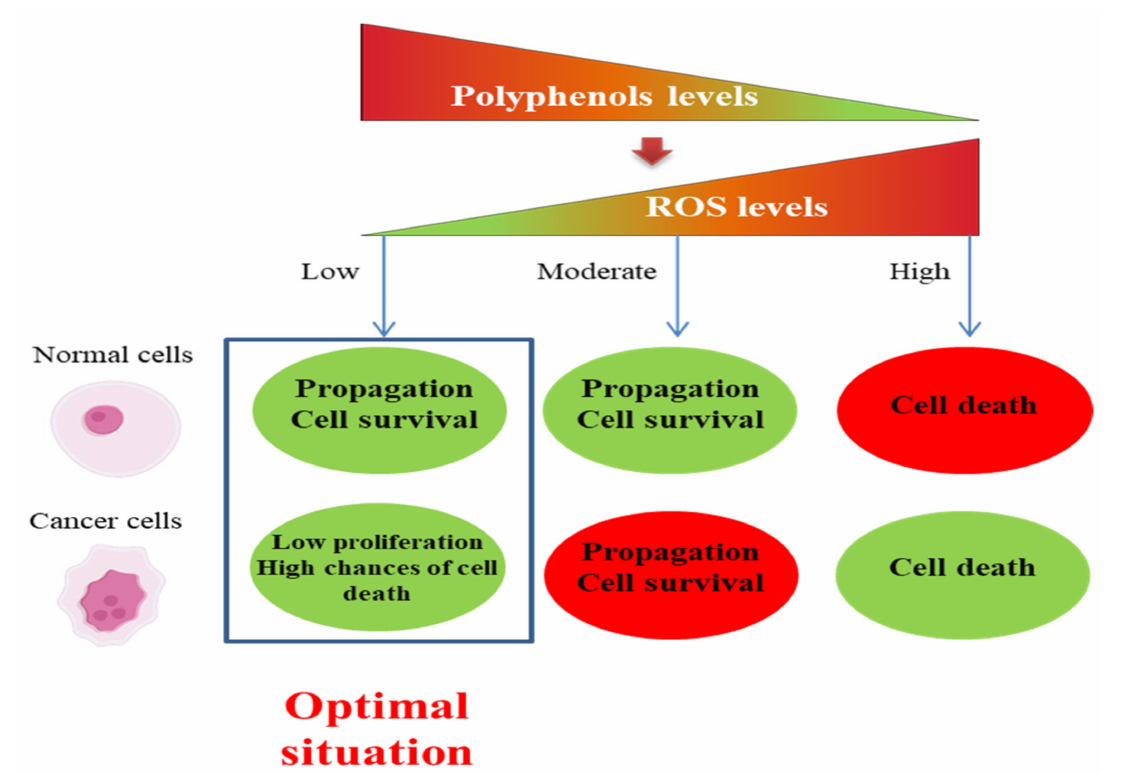
Figure 3. ROS as a “double edged sword” and the role of polyphenols [13]. ROS can oxidize the nucleobases including guanine, leading to DNA damage. Errors can creep in during the repair processes of these modified bases, leading to